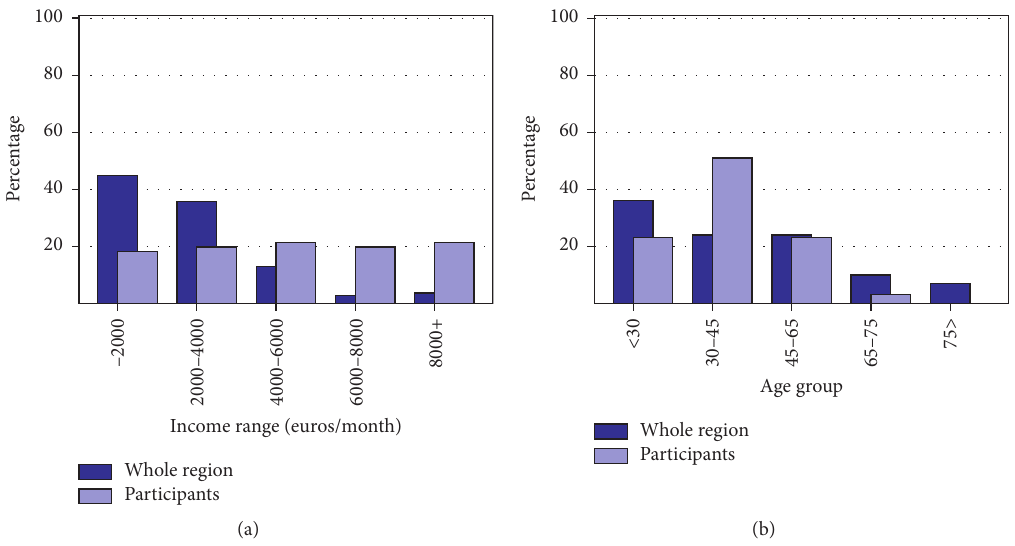
Figure 2: Income and age distribution of participants as well as that of the whole Helsinki region.